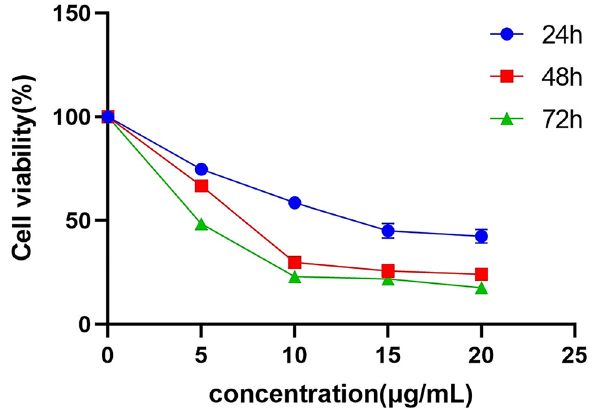
Figure 8. Through the CCK-8 experiment, RP inhibited the proliferation of CC cells. SW480 cells were treated with RP at different concentrations for 24, 48, and 72 h. The data are expressed as the mean ± SD of three separate